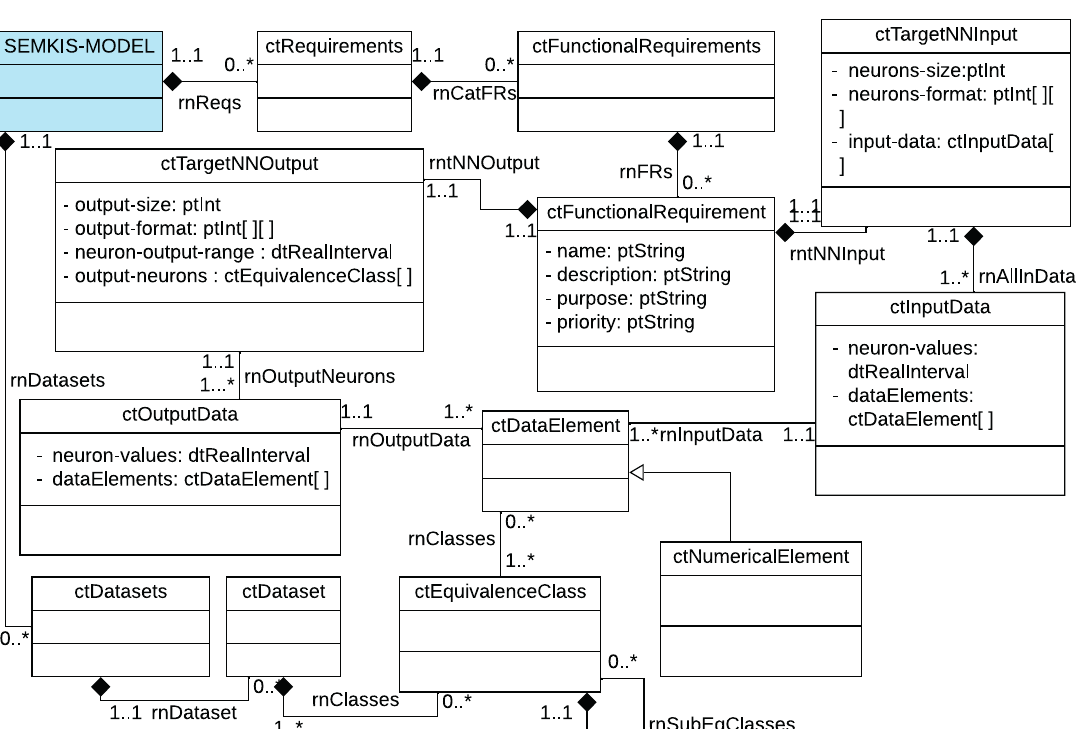
Figure 2. SEMKIS-DSL Metamodel: Dataset specification concepts.